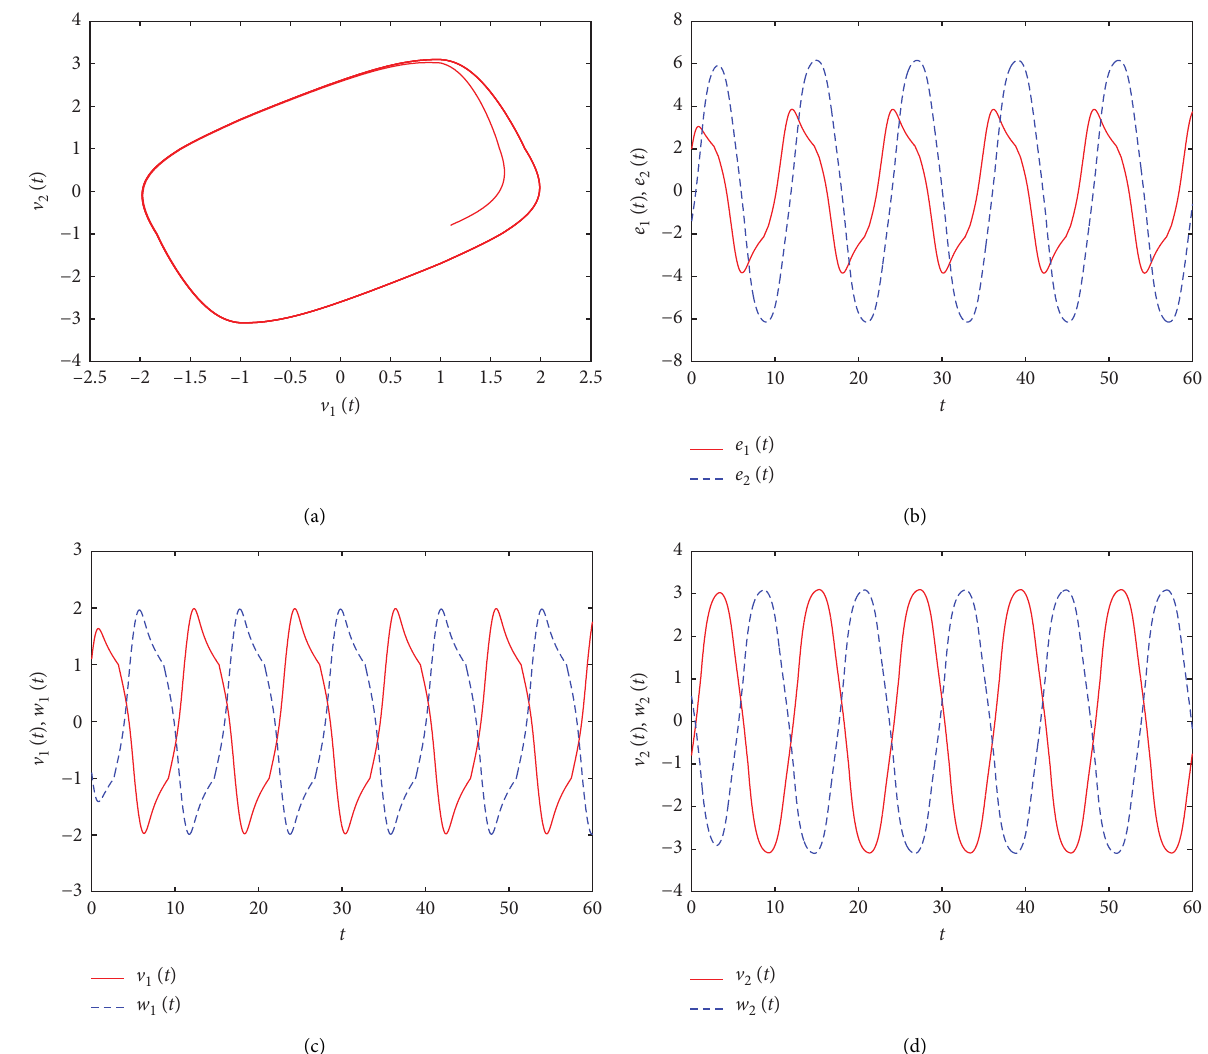
Figure 1: The chaotic behavior, error signal and state trajectories of the derive FOMNN (46), and the response FOMNN (8) without a